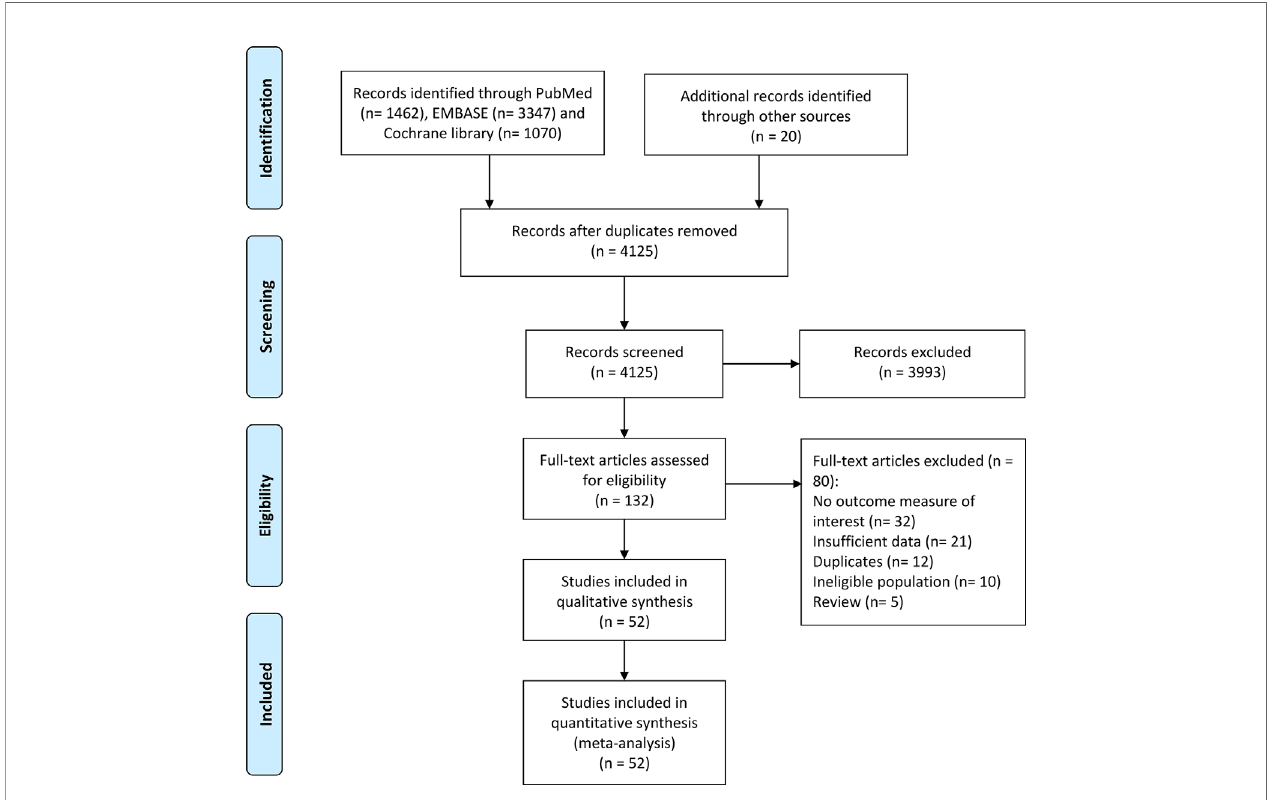
FIGURE 1 | Flow chart of the article identi fi cation, inclusion, and